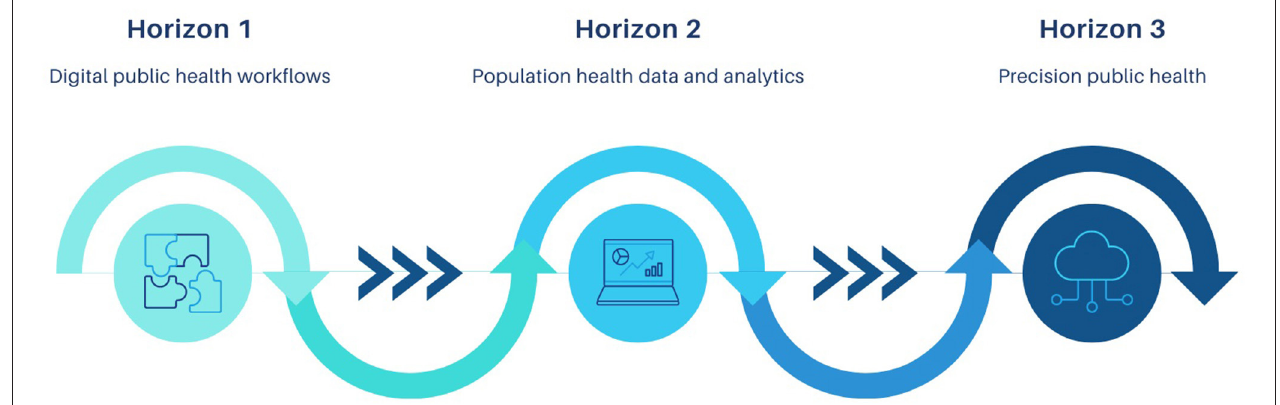
FIGURE 1 | Three horizons roadmap for precision public health of noncommunicable